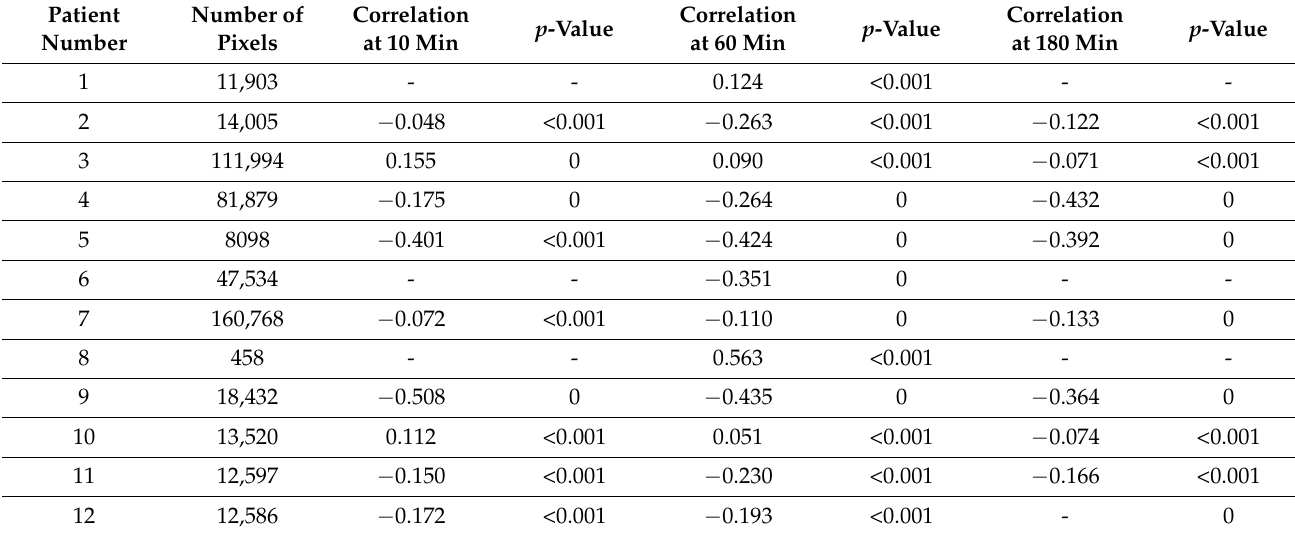
Table 4. Correlation results of 68Ga-FAPI uptake and T2w MRI